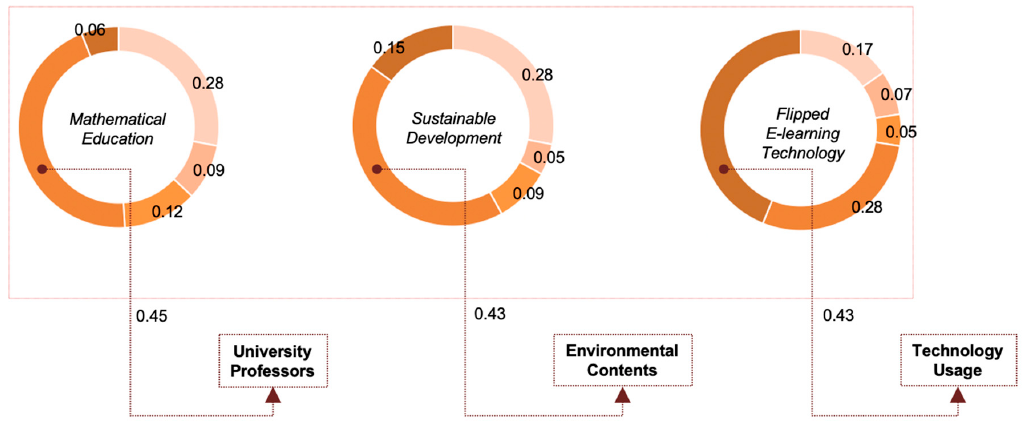
Figure 4. The network structure of the criteria for sustainable mathematics education through a flipped e-learning system that adapts to PSTs’ pedagogical changes.